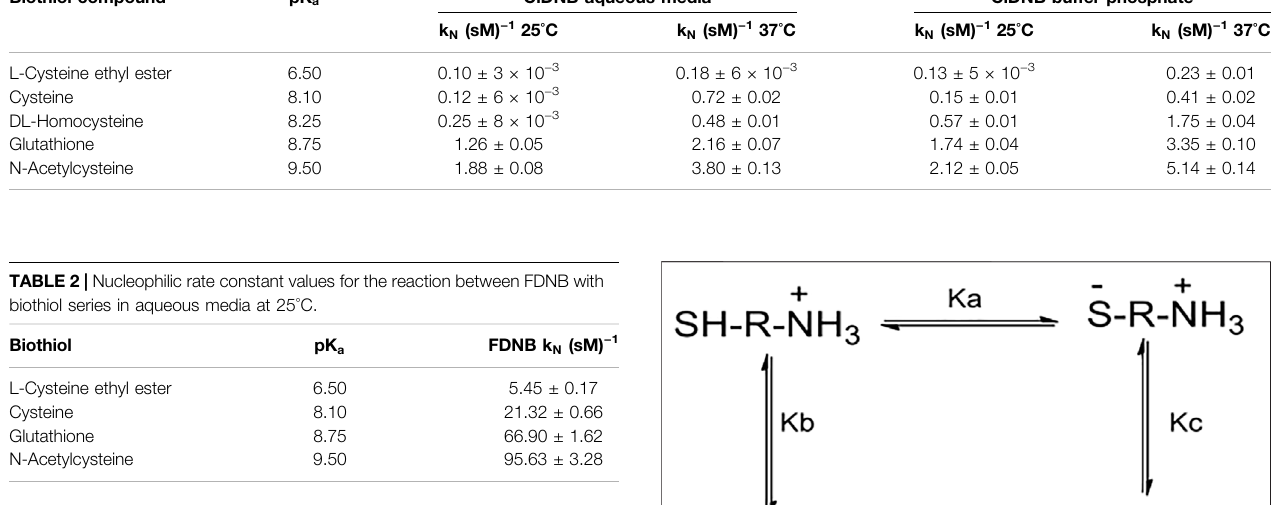
TABLE 1 | Nucleophilic rate constant values for the reaction between ClDNB with biothiol series in aqueous media and phosphate solution at 25 ° C and 37 ° C. Biothiol compound pK a